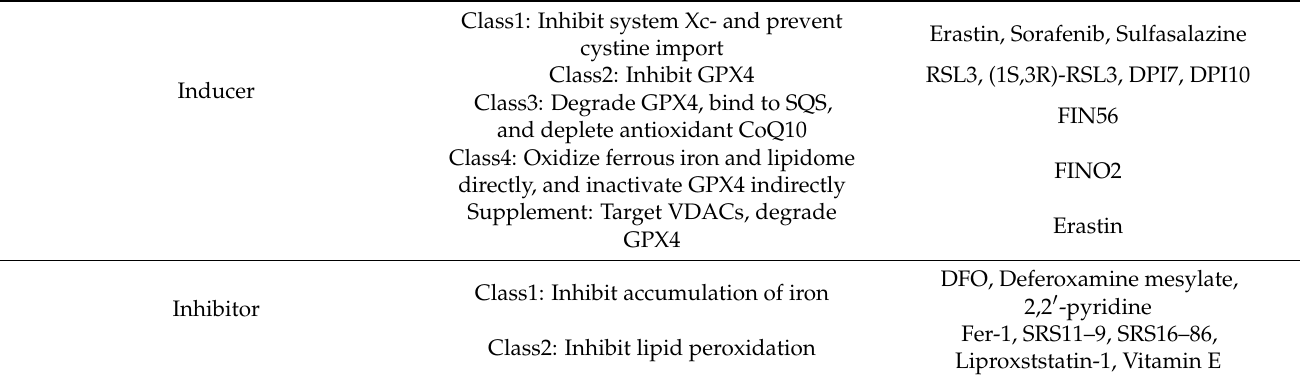
Table 2. The common inducers and inhibitors of ferroptosis.